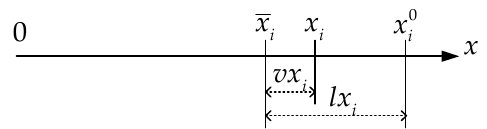
Figure 3. The residual v and reduced observation l of an image point i along x axis.